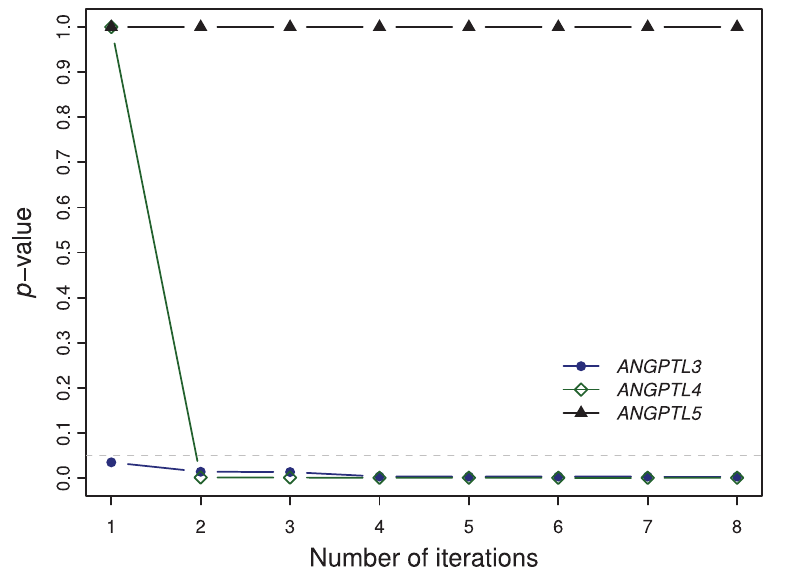
Figure 4. Changes of p -values of the three genes during the iteration process in the separate analysis. The p -values of the three genes in separate analysis using adaptive ridge regression (ARR) are plotted against the iteration process. P-values are calculated based on 0 : 5 x 2 distribution.